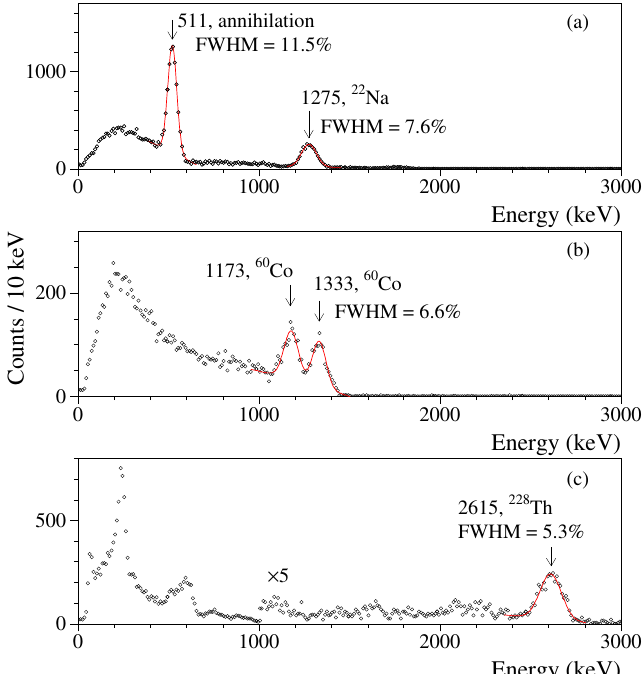
Figure 4. Energy spectra of 22 Na ( a ), 60 Co ( b ) and 228 Th ( c ) γ quanta measured by one of the CdWO 4 detectors. Fits of intensive γ peaks by Gaussian functions are shown by solid lines. Energies of γ quanta are in